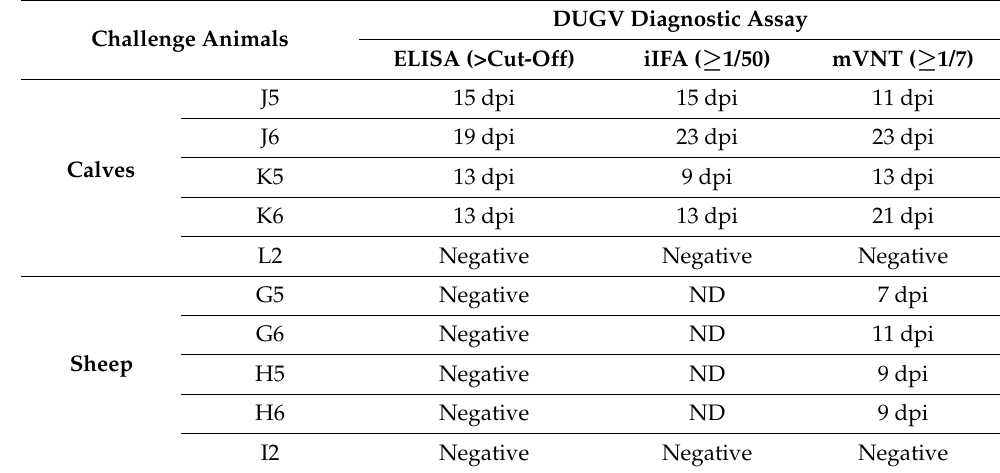
Table 2. Comparison of first detection of DUGV antibodies by individual assays. Challenge Animals